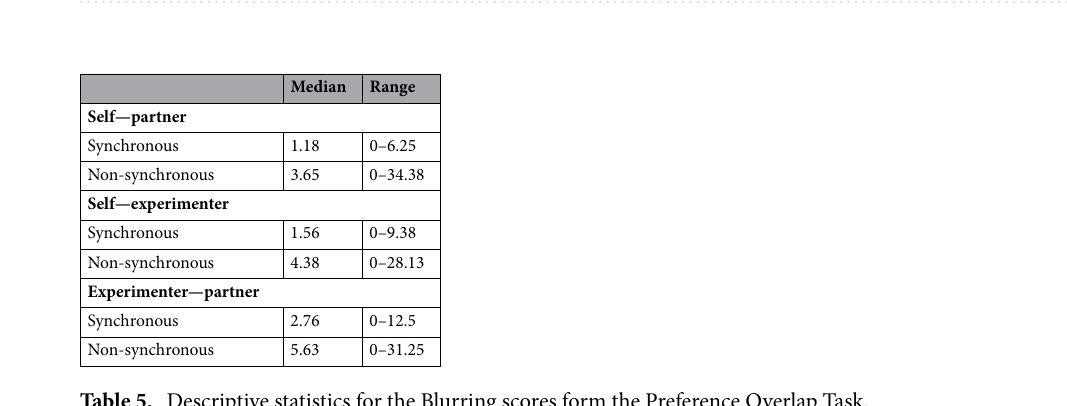
Table 4. Descriptive statistics for the Overlap scores form the Preference Overlap Task.